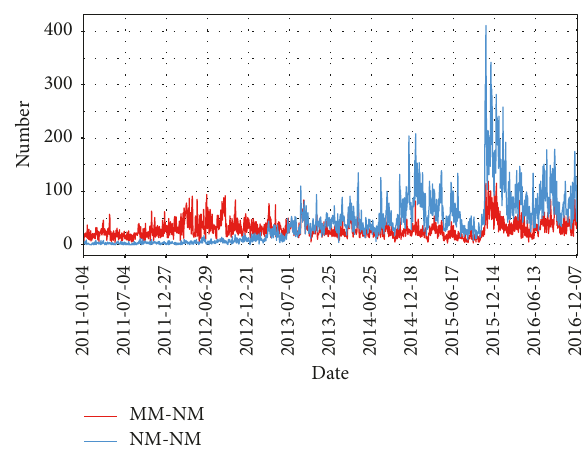
Figure 1: The daily amounts of news from mass media and new